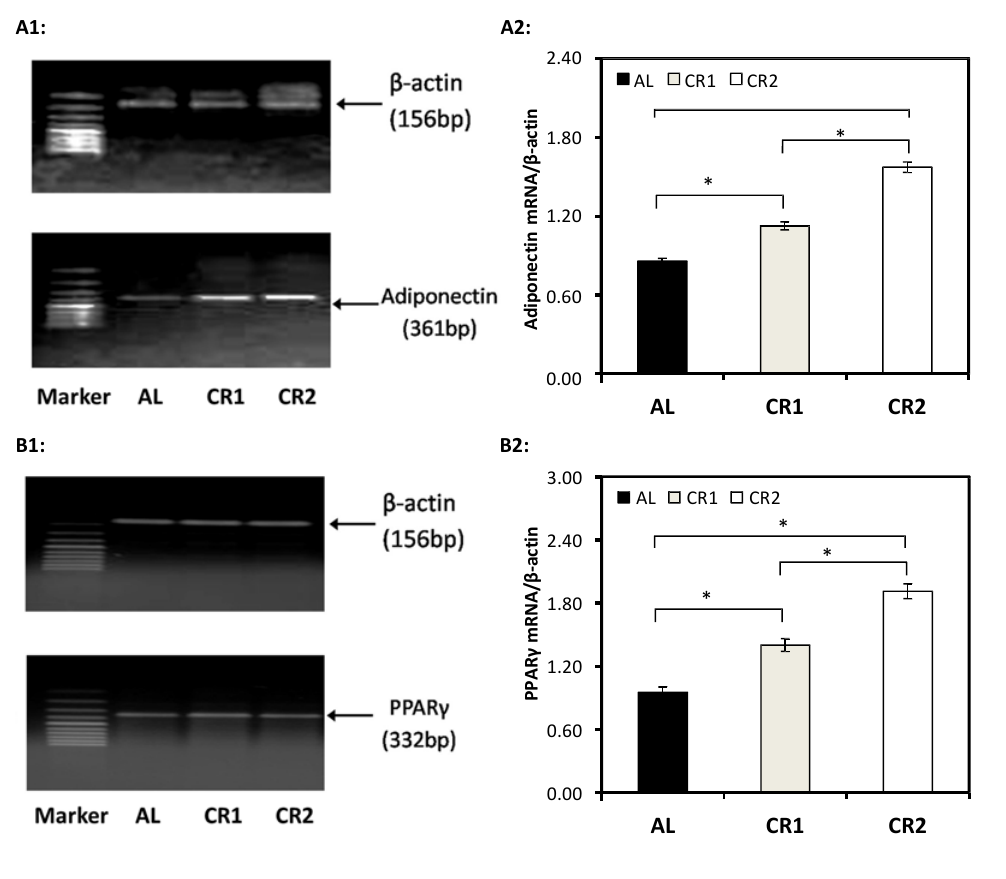
Figure 4. The effect of calorie restriction on the expressions of adiponectin and PPARγ in adipose tissues. ( A1 , B1 ) demonstrate the expression levels of mRNA of β-actin, adiponectin and PPARγ, respectively, quantified by RT-PCR. The expression levels (absorbance) of mRNA of adiponectin and PPARγ were then normalized against those of β-actin (served as loading control) ( A2, B2 ). One-way ANOVA followed by LSD-test was used to detect significant differences of the means, * p <